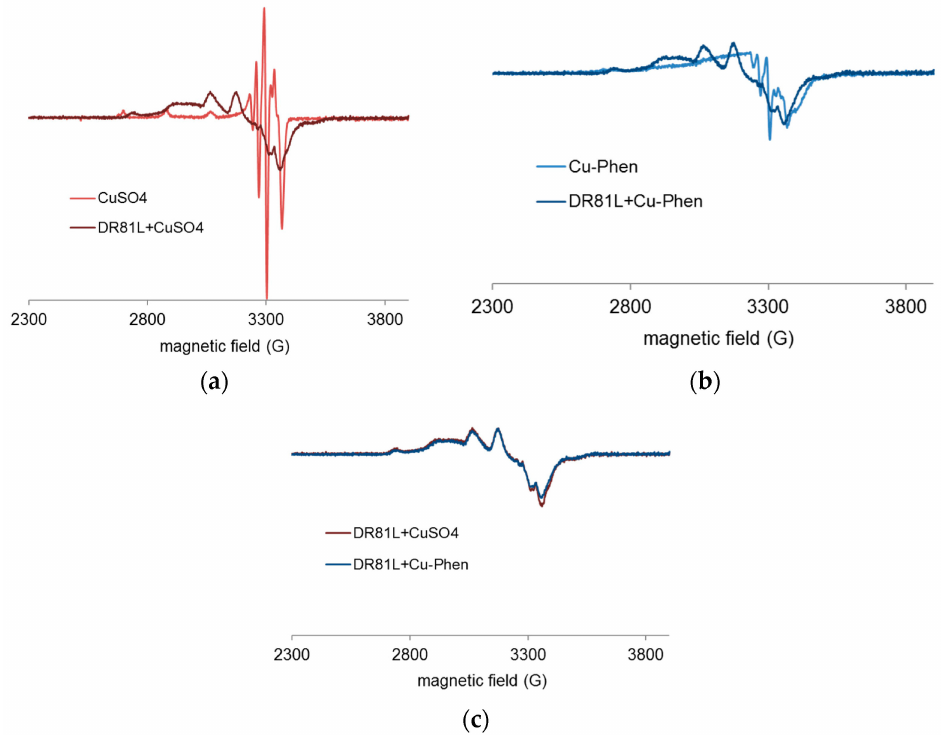
Figure 21. Experimental X-band EPR spectra recorded at 100 K in frozen aqueous solutions of ( a ) CuSO 4 and CuSO 4 + DR81 ( b ) Cu-Phen and Cu-Phen + DR81 ( c ) CuSO 4 + DR81 and Cu-Phen + DR81, at pH 12.3, with Cu:Phen molar ratio = 1:2, DR81:Cu molar ratio = 10:1.5 and [Cu] = 1.5 mM.